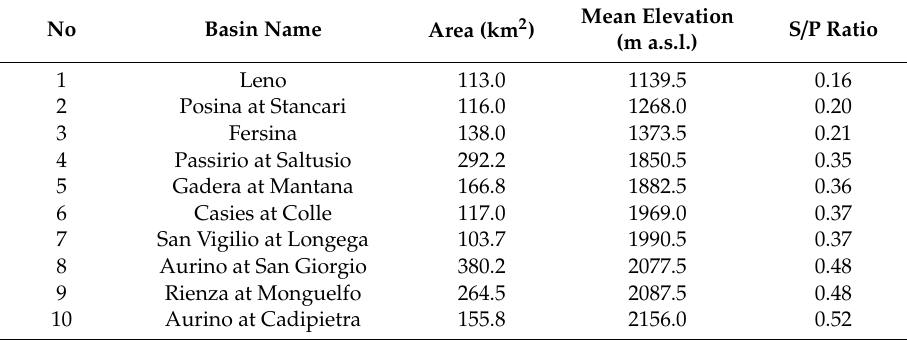
Figure 1 Map of the study basins in Italy. Figure 1. Map of the study basins in Italy. Table 1. Main characteristics of the study basins. The basins are ranked (e.g., from 1 to 17) according to their ratio between solid precipitation and total precipitation (S / P ratio). A high S / P ratio indicates runo ff regimes dominated by snow accumulation and melt while low S / P ratio indicates runo ff regimes more dominated by precipitation events